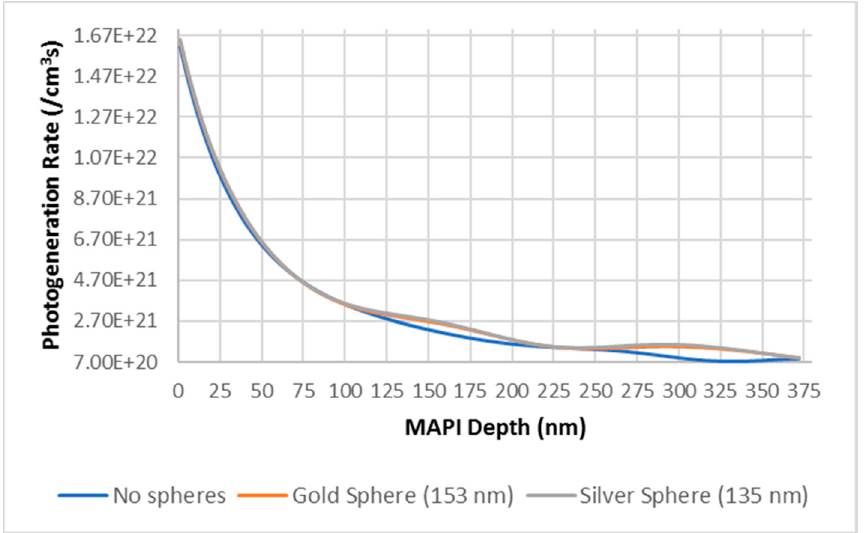
Figure 6. Solar cell generation rate vs. MAPI layer depth for the cell with and without Au and Ag NPs.